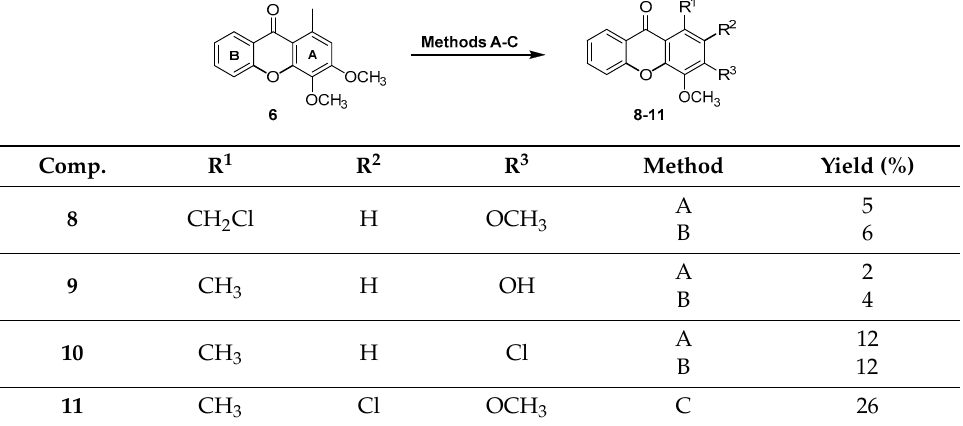
Table 1. Synthesis of chlorinated derivatives of 3,4-dimethoxy-1-methyl-9 H -xanthen-9-one ( 6 ). Comp.